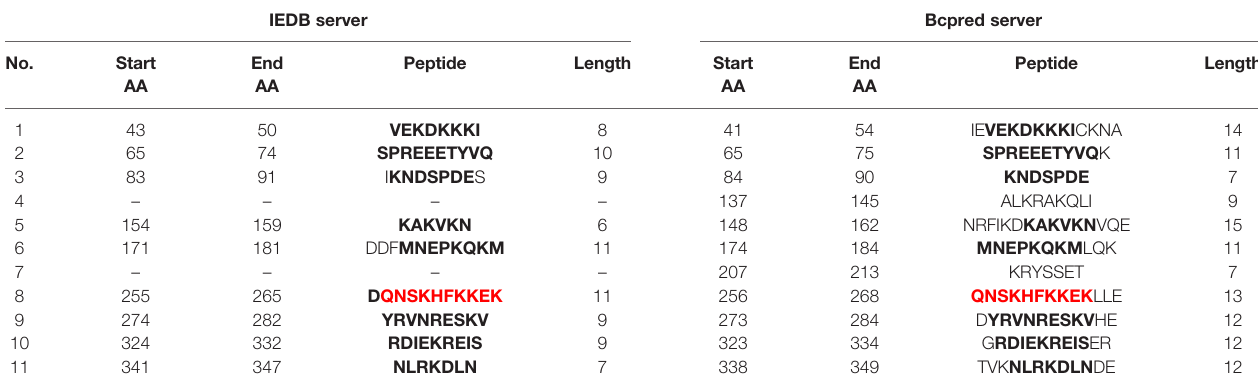
The common epitopes predicted by both servers are indicated in bold, and the conserved epitopes among all species as mentioned in results are indicated in red color. AA, amino